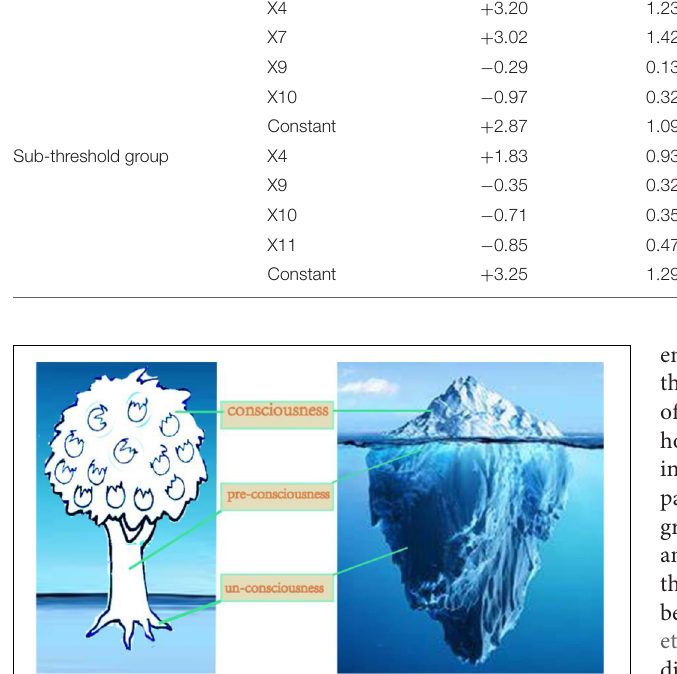
TABLE 5 | Logistic regression analysis of the quantitative indexes of tree drawings in depression and sub-threshold. Group Characteristic B S.E. Wald df Sig Exp(B) Depression group X1 − 3 . 18